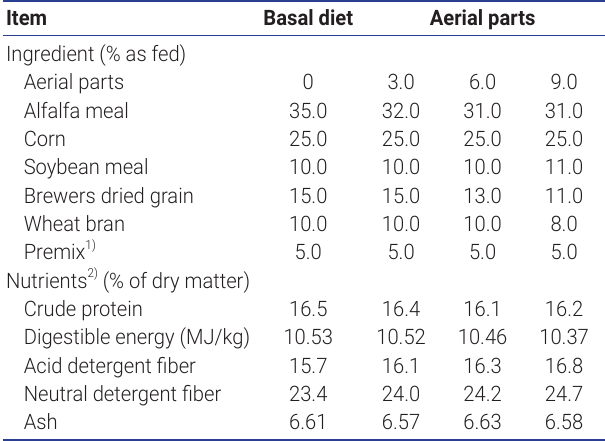
Table 2. Ingredients and nutrient levels of basal diet and diets con- taining Salvia miltiorrhiza aerial